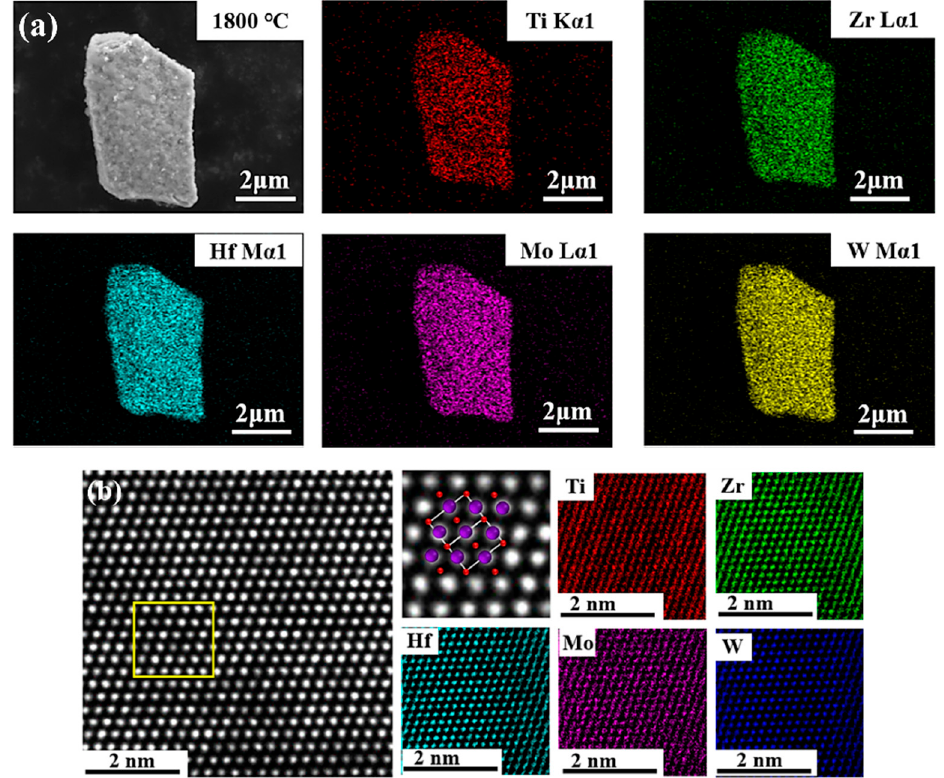
Figure 8. ( a ) SEM image of Ti 1.00 Zr 1.01 Hf 1.04 Mo 1.01 W 1.01 C 4.93 pyrolyzed at 1800 °C and corresponding EDS maps at the microscale; ( b ) HAADF micrograph along (110) zone axis and corresponding STEM-EDS maps of as-received Ti 1.00 Zr 1.01 Hf 1.04 Mo 1.01 W 1.01 C 4.93 pyrolyzed at 1800 °C [102].